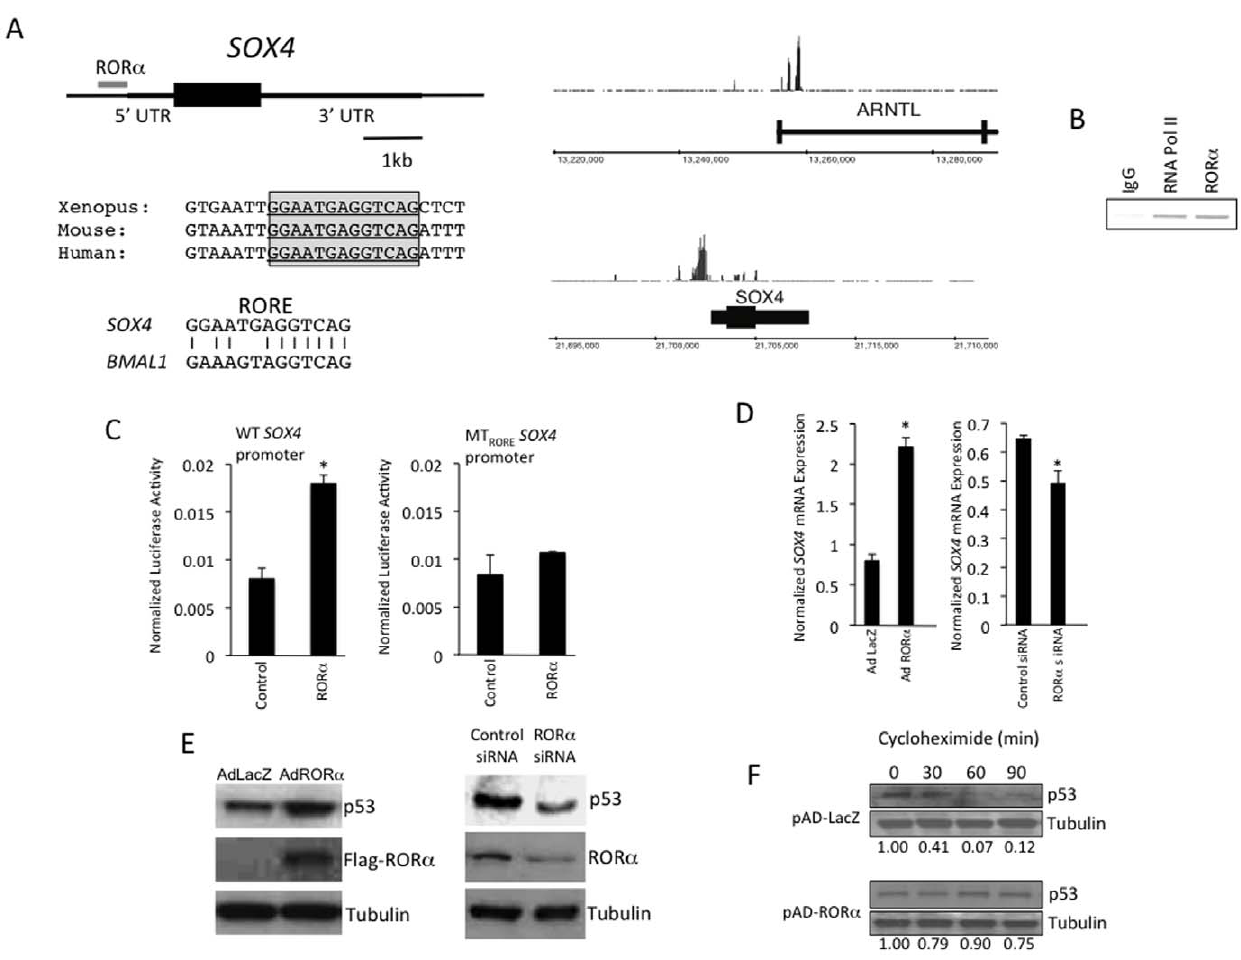
Figure 1. Identification of a RORE in the SOX4 promoter. A) Schematic representing the SOX4 gene. The single exon gene is shown in the diagram the untranslated regions are also shown. The area where significant ROR a occupancy was detected in the ChIP-microarray screen is indicated above the gene. The putative RORE is shown below the gene structure and alignment illustrates absolute conservation between xenopus, mouse and human sequences. The RORE is indicated by the underlined sequence. Alignment of the putative SOX4 RORE with the prototypic RORE from the prototypic ROR target gene, BMAL1 . Right Panel: Screen shot from genome browser indicating regions generating signal from the ChIP/chip study on both SOX4 and the positive control ARNTL ( BMAL1 ). B) Chromatin immunoprecipitation assessing the occupancy of ROR a at the SOX4 promoter. IgG was used as a negative control and RNA polII was used as a positive control. C) Cotransfection assay where a luciferase reporter under the direction of the SOX4 promoter was transfected into HEK 293 cells along with a vector directing the expression of ROR a . Inclusion of ROR a results in stimulation of luciferase expression. The second panel demonstrates that when the RORE is mutated in the SOX4 promoter, which inhibits the ability of ROR a to bind, ROR a no longer has the ability to activate transcription of this reporter. WT, indicates wild type and MT, indicates mutant. Empty expression vector was included in the control wells. D) Adenoviral overexpression of ROR a in HepG2 cells results in stimulation of SOX4 mRNA expression relative to the LacZ adenovirus control. Suppression of expression of ROR a using siRNA results in a reduction of SOX4 mRNA. *, indicates p , 0.05. E) Western blot illustrating that overexpression of ROR a results in increased p53 protein while suppression of ROR a expression results in decreased p53 protein expression. F) Analysis of the effect of ROR a overexpression on the half-life of p53. HEK293 cells overexpressing either LacZ (control) or ROR a were treated with cycloheximide for various amounts of time (0, 10, 60, 90 min) and p53 protein was assessed by western analysis and normalized to tubulin expression. Densitometry was used to assess expression and was signal was normalized to tubulin and the normalized relative (to time 0) expression is indicated below the blots. p53 displayed a half-life of 22 6 6 min (mean 6 S.E.) in the absence of ROR a and a half-life . 90 min with ROR a overexpressed. doi:10.1371/journal.pone.0034921.g001 normalized to control reporter. The values indicated represent the serum (Invitrogen, Carlsbad, CA) at 37 u C under 5% CO 2 . 24 h means 6 S.E. from four independently transfected wells. The prior to transfection, HEK293 cells were plated in 96-well plates at experiments were repeated at least three times. a density of 15 6 10 3 cells/well. Transfections were performed using Lipofectamine TM 2000 (Invitrogen). Each well was trans- fected with 20 ng pGL4.73, 50 ng ROR and 100 ng pTAL-Luc or Overexpression of ROR a and siRNA Knockdown mutant. Eight hours post-transfection, the cells were treated with The HepG2 cells (ATCC) were maintained in MEM supple- vehicle or ligands. Twenty-four hours post-treatment, the mented with 10% fetal bovine serum at 37 u C under 5% CO2. luciferase activity was measured using the Dual-GloTM luciferase HepG2 cells were plated in 6-well plate one day before infection. assay system (Promega). The value from experimental reporter was The cells were infected with adenovirus for 24 hours and then